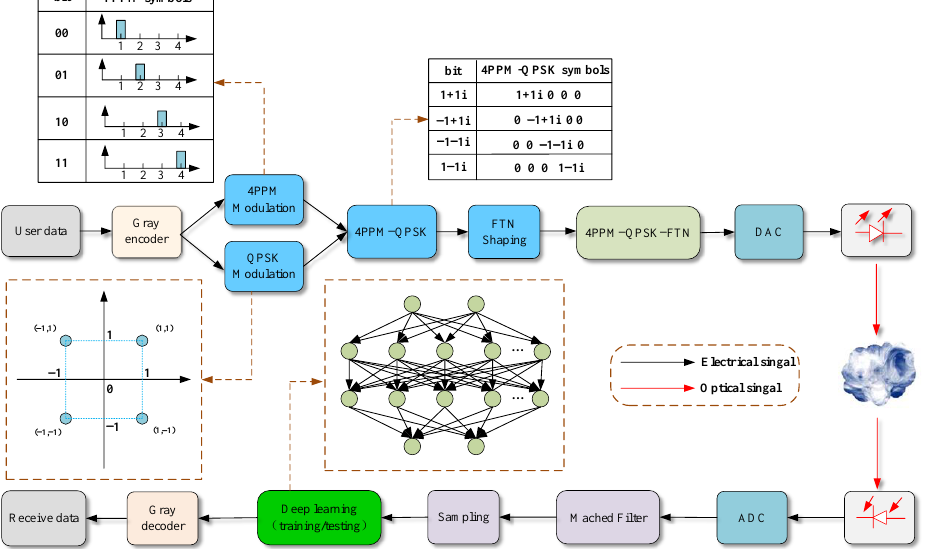
Figure 1. Schematic of atmospheric optical communication system based on the 4PPM–QPSK–FTN modulation mode.